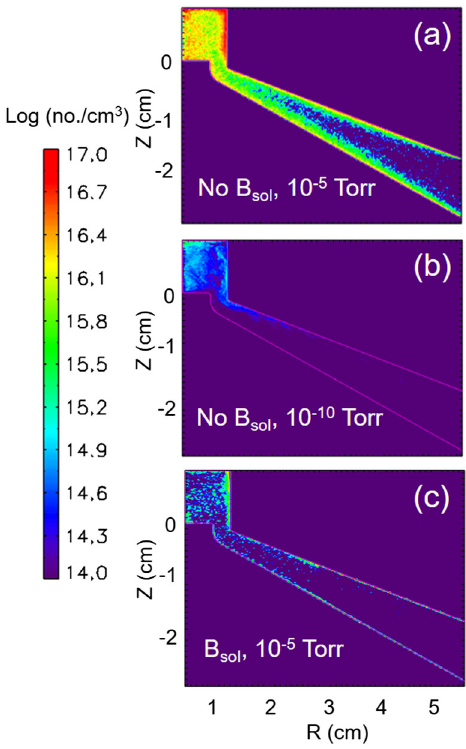
¼ 1 ) and (b) 10 − 10 Torr ML